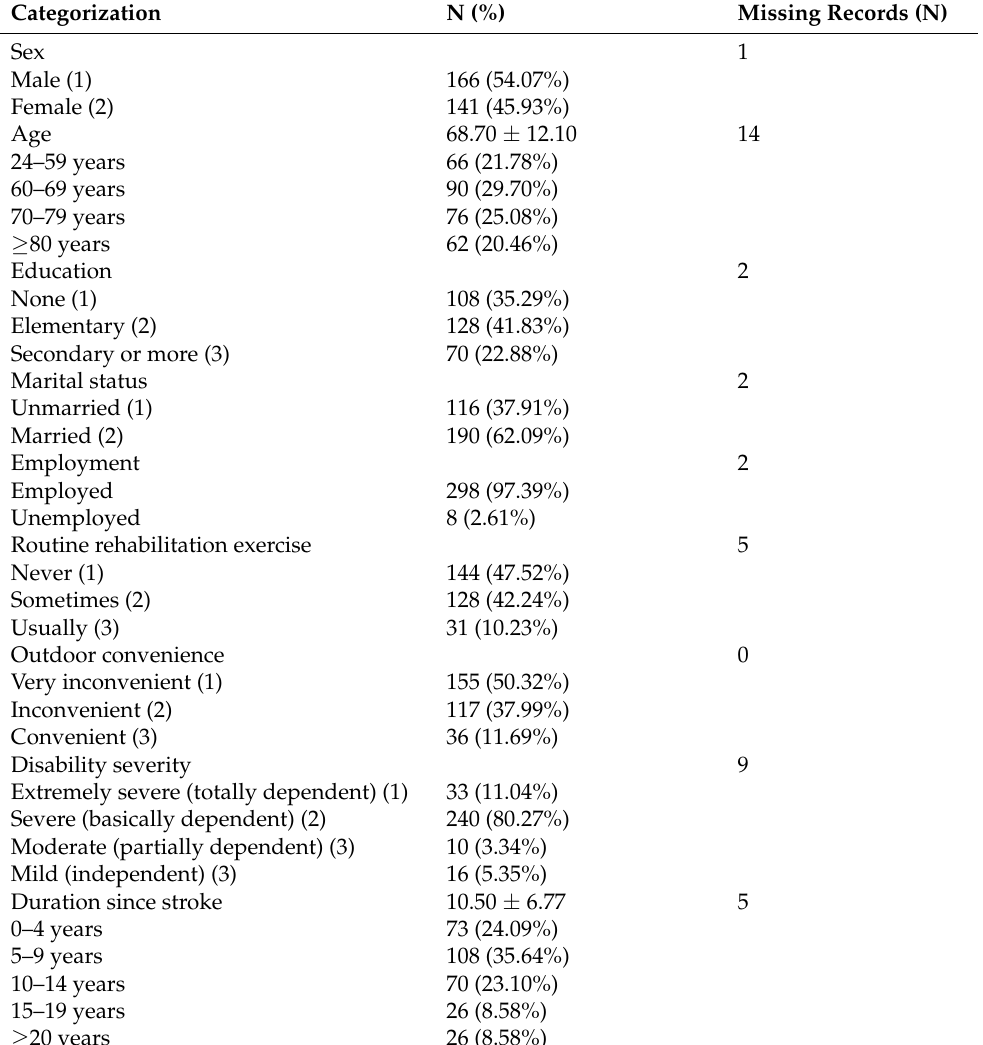
Table 1. Demographic characteristics of the 308